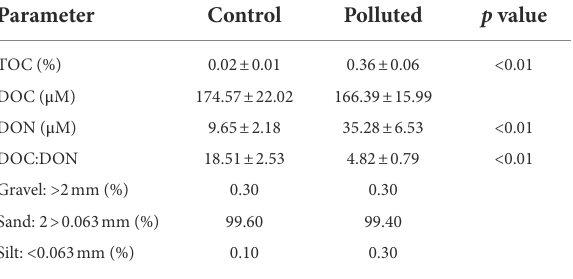
TABLE 1 Sediment organic content and grain size distribution (n = 6).